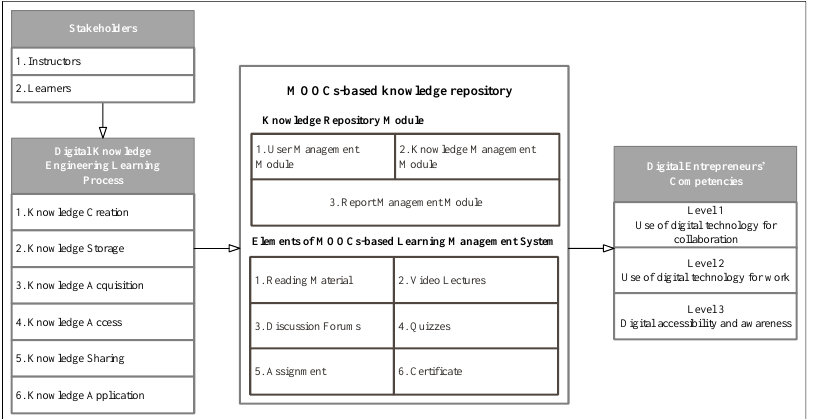
Fig. 2. Conceptual Framework for the Development of a MOOCs-Based Knowledge Repository to Enhance Digital Entrepreneurs’ Competencies [12]